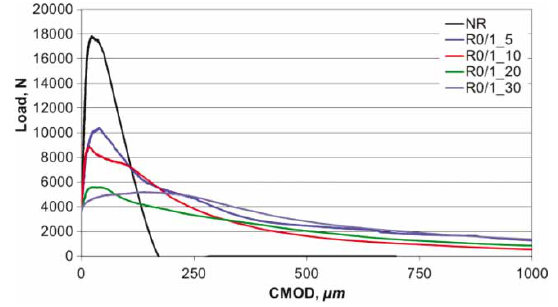
Fig. 6. The function of stress and CMOD when 0/1 fraction is used